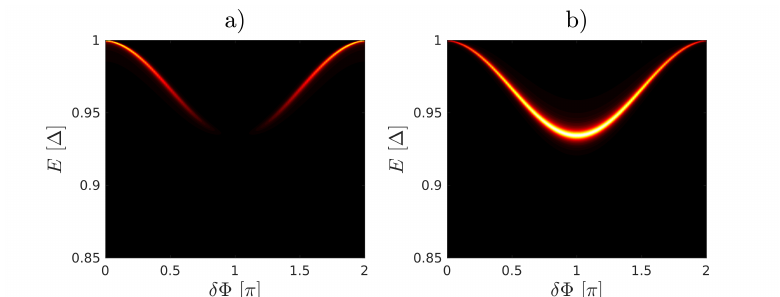
Figure A2. The LDOS for electron ( a ) and hole ( b ) quasiparticles as a function of δ Φ on molecular site 22 of the Andreev interferometer shown in Figure 6c of the main text and in Figure A1. In these calculations ε 3 = − 0.50 γ 0 .